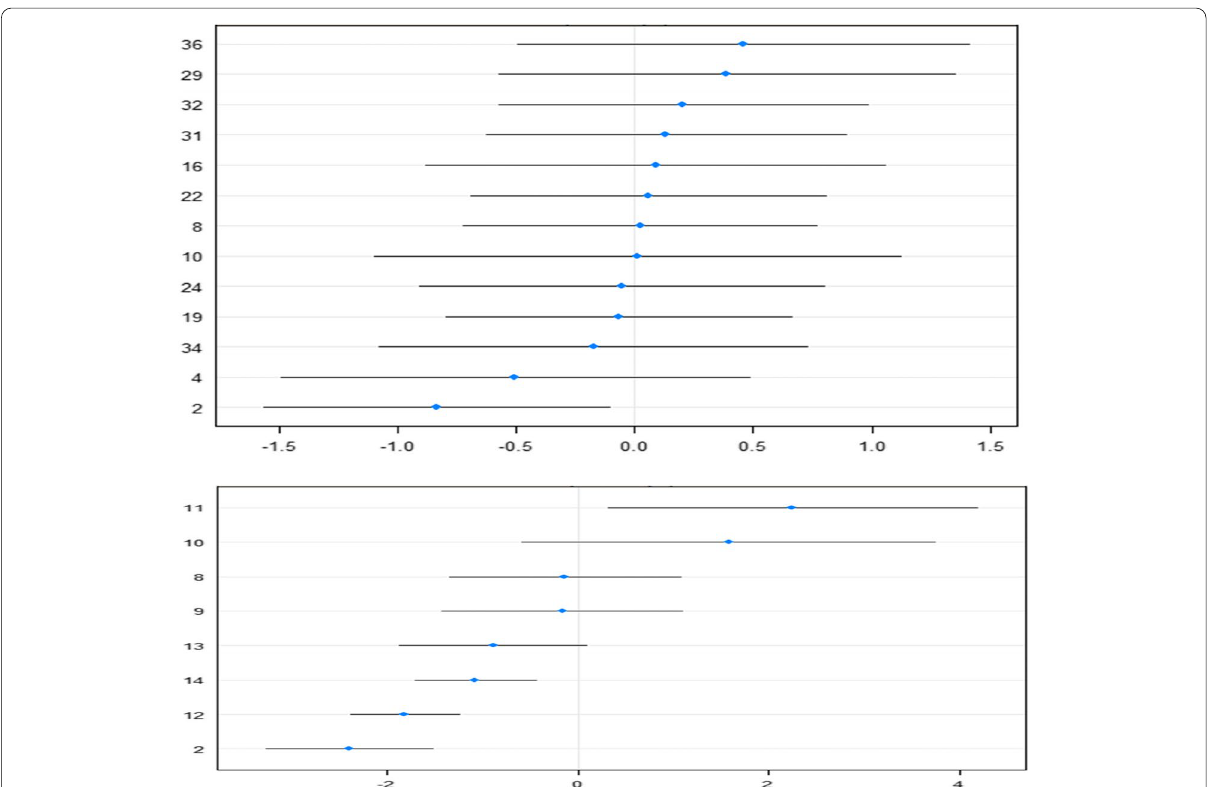
Fig. 4 The variation in the BLUP values of the in vitro survival of uncontaminated families (top) of proliferating ash shoots that were subjected to the root inducing treatment, as arranged from best to worst. The bottom figure shows the variation in the BLUP values of the same plants, but arranged by trial batch, and arranged from best to worst. The blue dots represent the best linear unbiased predictors (BLUPs) for the effect of clonal family or batch for in vitro survival and the black bars show the 95% confidence intervals. Note that the family effect on the variation in the survival of the plantlets undergoing root induction in vitro is not statistically significant, while the batch effect is